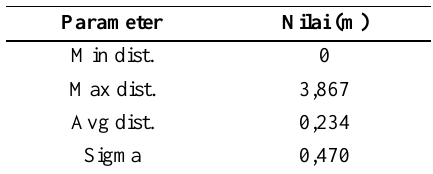
Table 4. Point cloud position deviation value statistic to 3D model